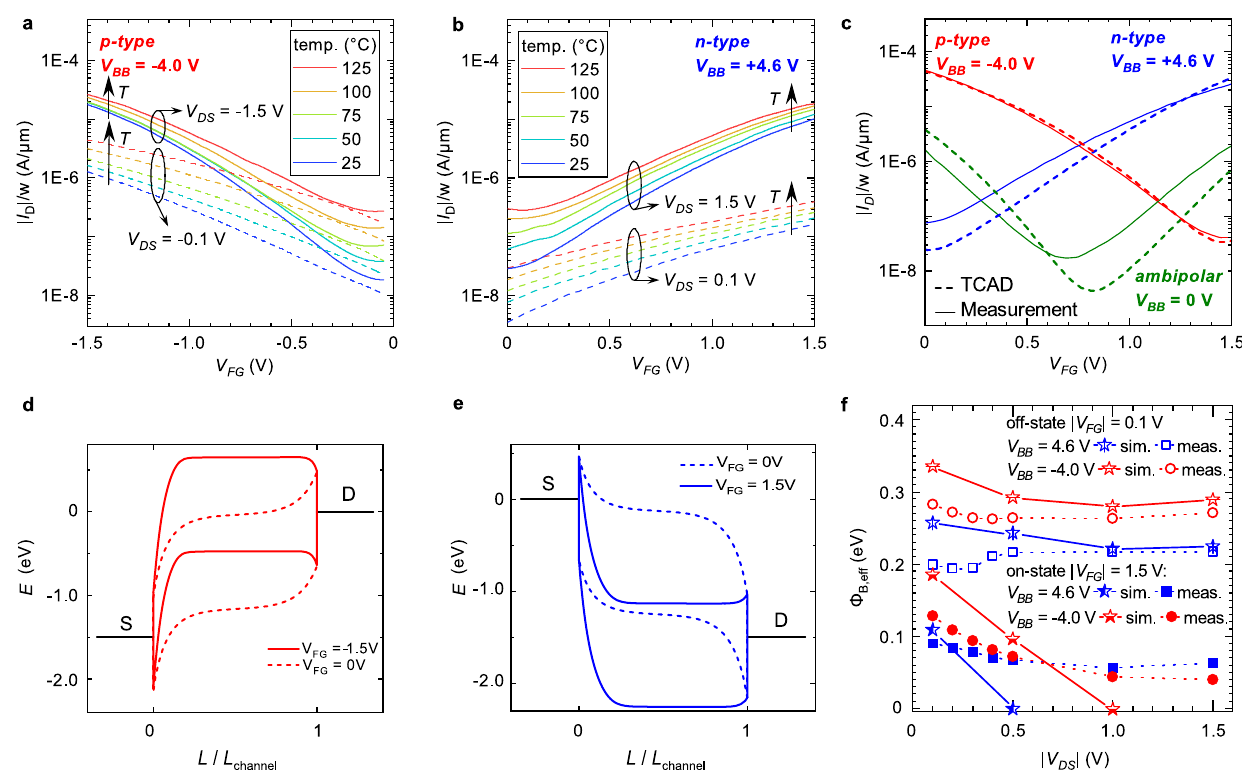
Fig. 2 | Analysis ofback-bias RFET device physics.a , b p-type and n-type transfer characteristics in the temperature range from 25 to 125°C, respectively. c Fitting of the measured transfer characteristics by TCAD simulations using a process simula- tionapproach. d , e Banddiagramsfora ∣ V DS ∣ of1.5Vforp-type(red, V BB = – 4.0V)and n-type (blue, V BB =4.6V) program, respectively. Solid lines represent ON-states,